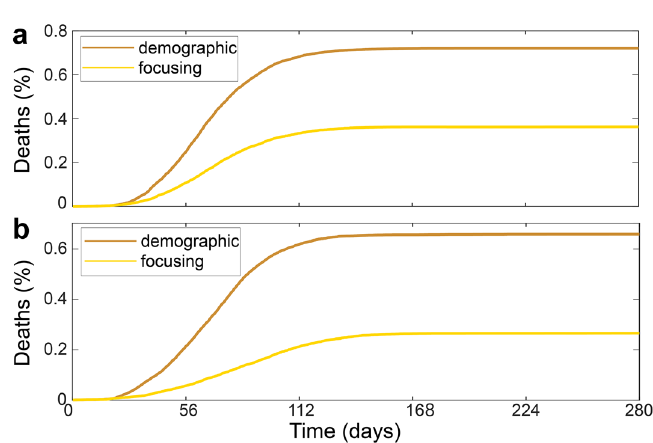
Figure 6. Fraction of deaths over time for ( a ) active particles with inertia and self-propulsion and ( b ) particles with different